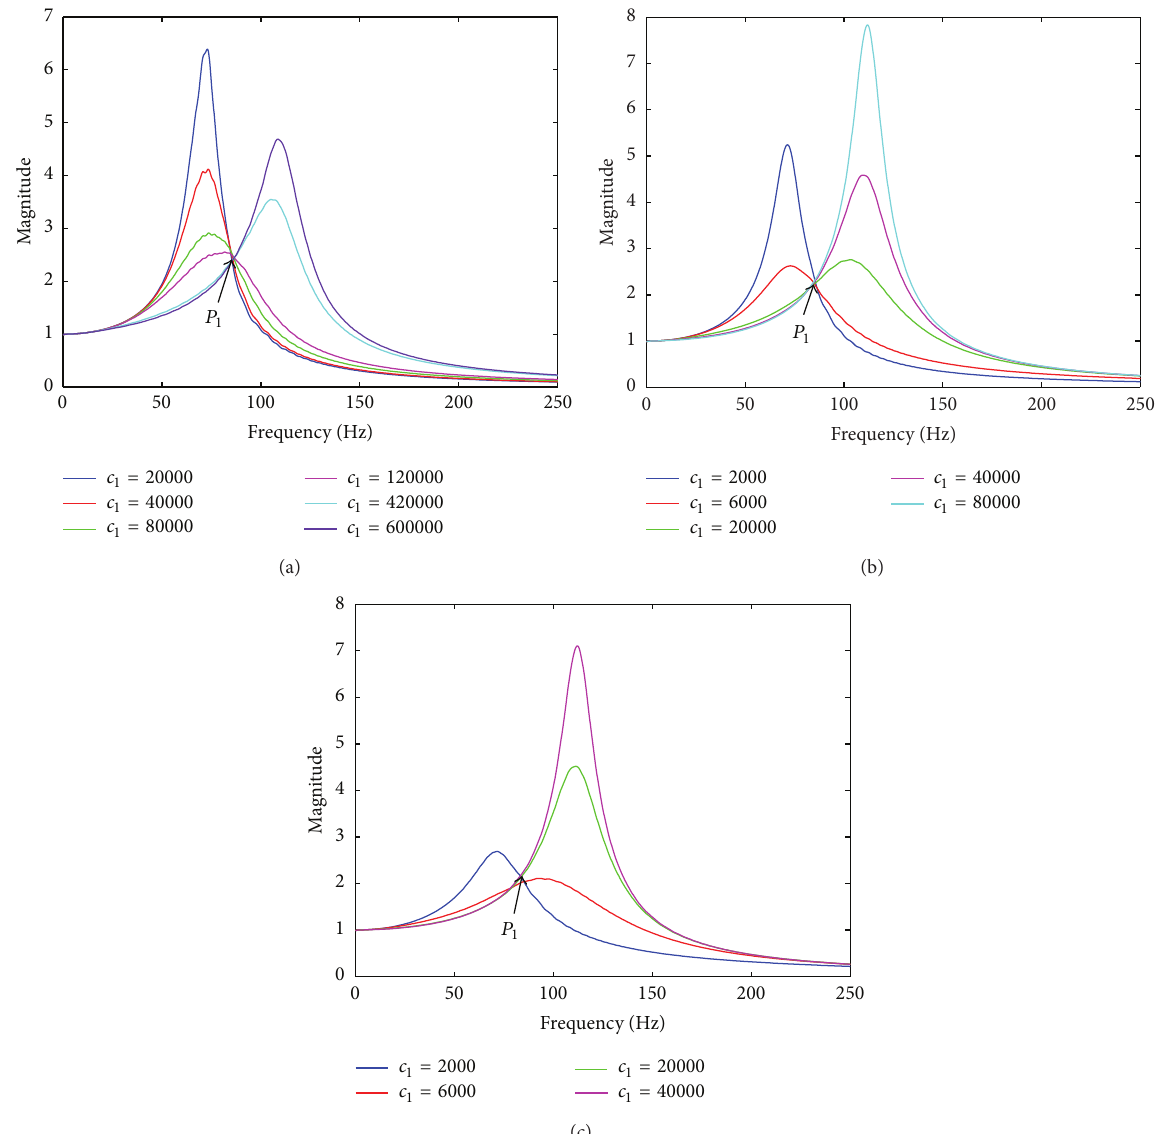
Figure 18: Force transmissibility curves of CM under 50 N FE cases. (a) 𝑛 1 = 1.5 ; (b) 𝑛 1 = 1 ; (c) 𝑛 1 = 0.85 .